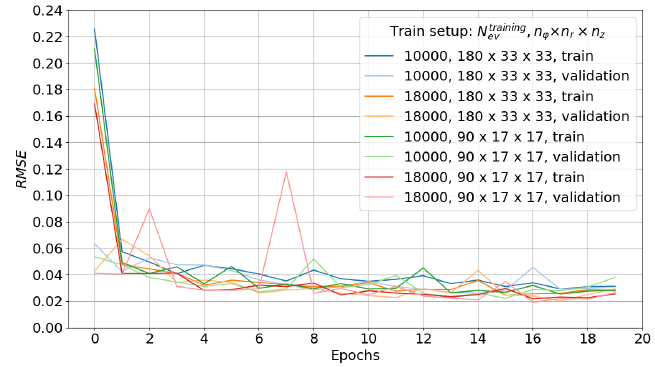
Figure 2. Architecture of the standard implementation of the U-Net. Figure 3. The RMSE as a function of the number of the epochs for the training of the U-Net using a 90 17 17 and a 180 33 33 grid and di ff erent numbers of training events (10000 and 18000). × × × × maps and a set of average density maps. A nominal average space-charge density map is defined as the average of the density maps of all the random samples. Di ff erent average by studying the Root Mean Squared Error (RMSE) as a function of the number of